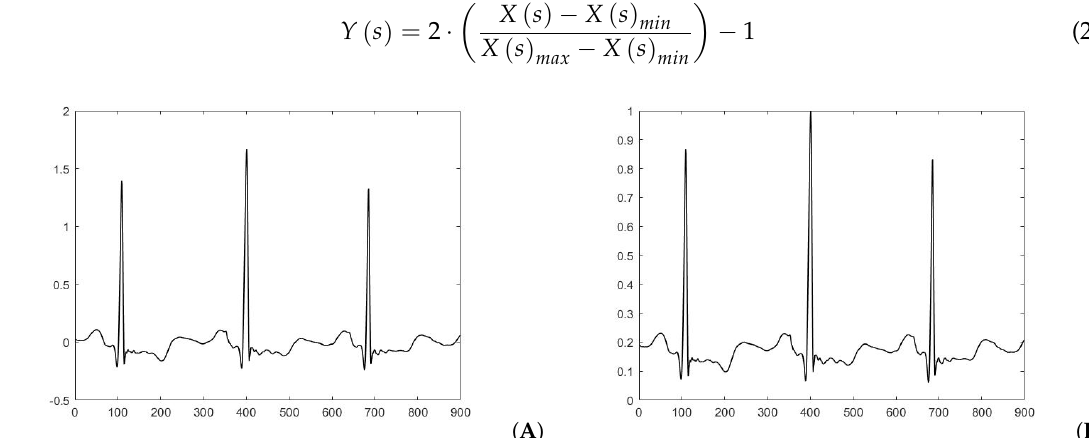
Figure 5. ( A ) Signal before normalization. ( B ) Signal after normalization.